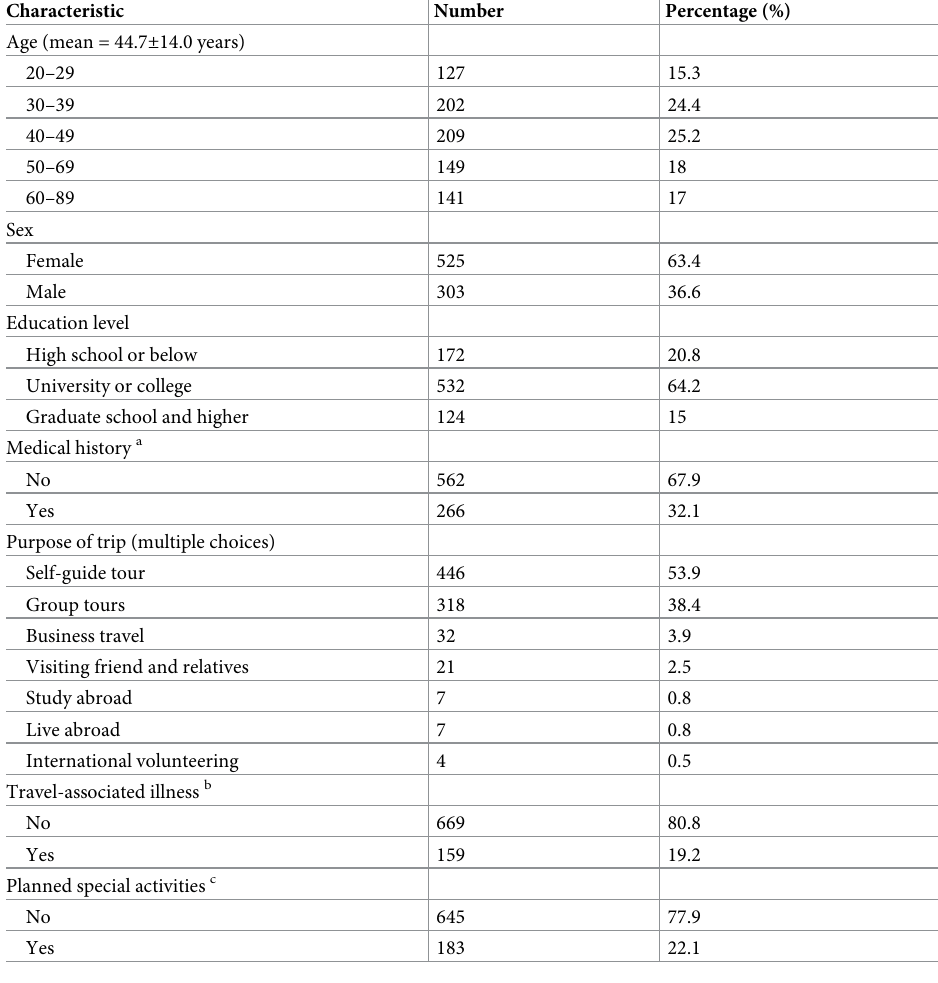
Table 1. Basic characteristics of survey respondents (N =